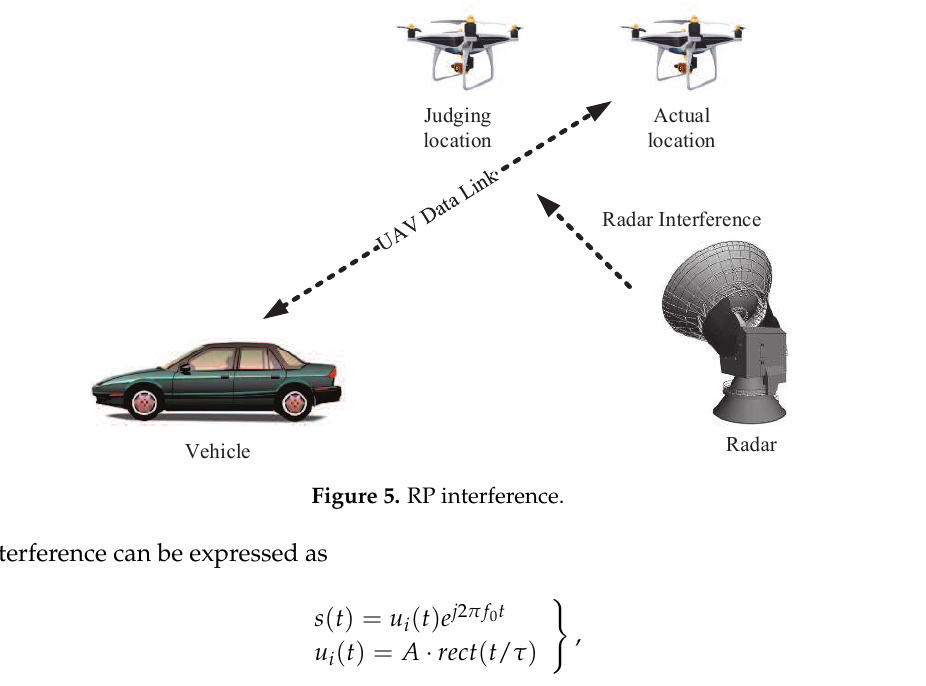
Figure 5. RP interference.